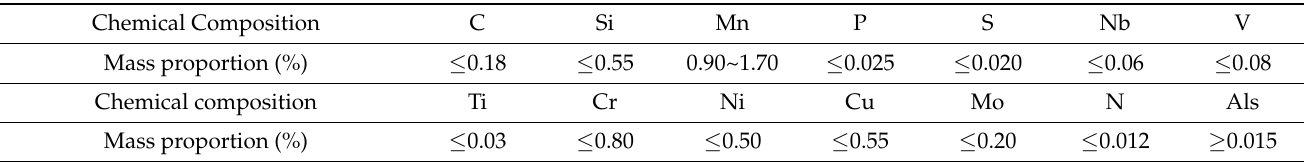
Table 1. Chemical composition of steel Q345qD